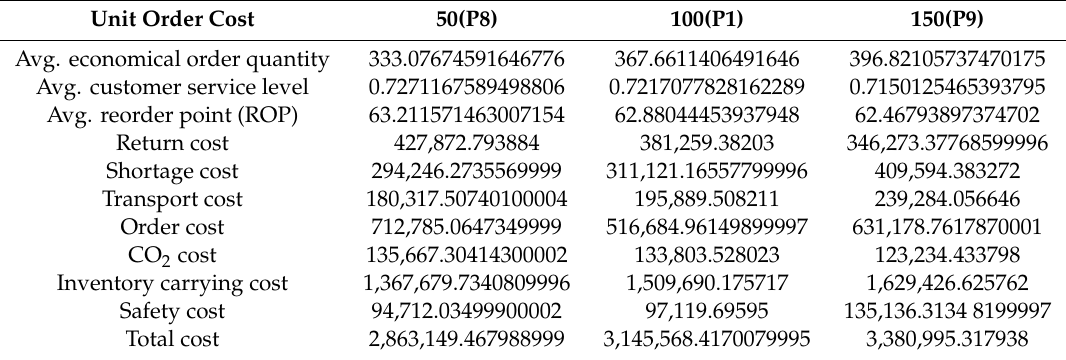
Table 17. The results of the sensitivity analysis for order cost based on the ROPIRPSDRCO 2 mode. Unit Order Cost